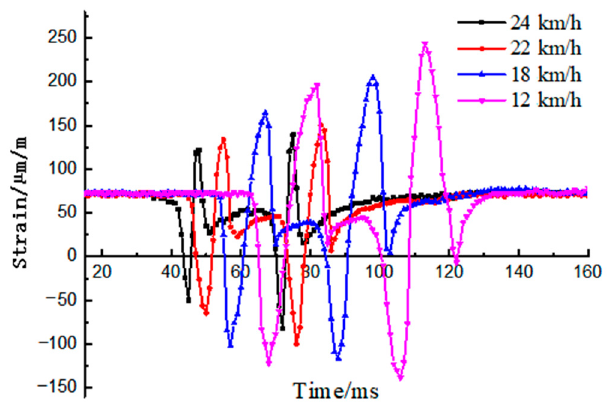
Figure 10. Relationship between vehicle speed and maximum longitudinal tensile strain at the base of the layer.